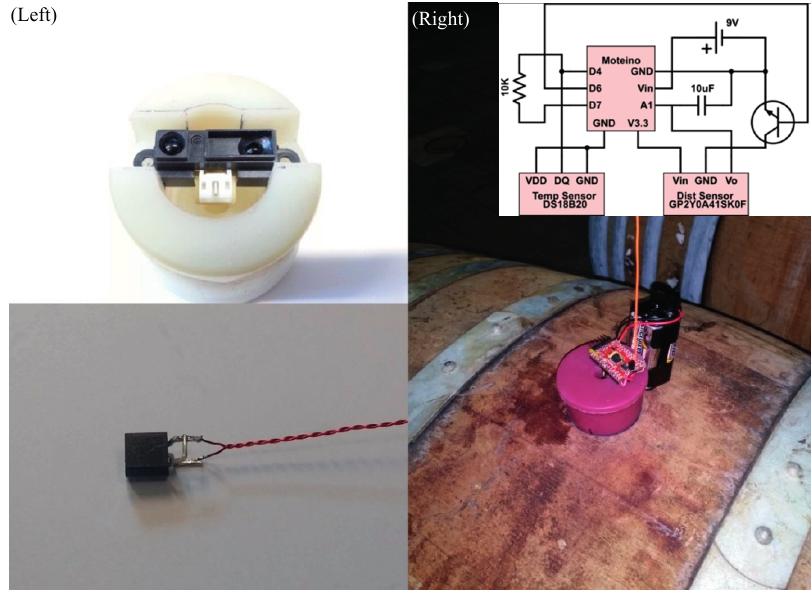
Figure 2. ( Left ) The distance sensor inside a bung and a naked temperature sensor; ( Right ) An assembled subsystem on a wine barrel and its schematic as the